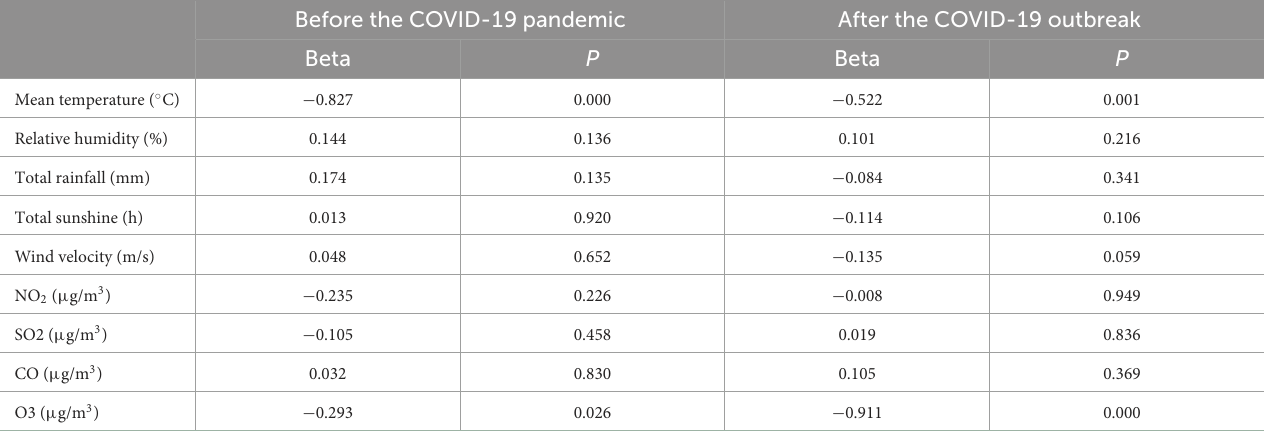
TABLE 6 Multiple stepwise regression analysis of the relationship between meteorological and environmental factors and bronchial asthma development before and after the COVID-19 pandemic. Before the COVID-19 pandemic